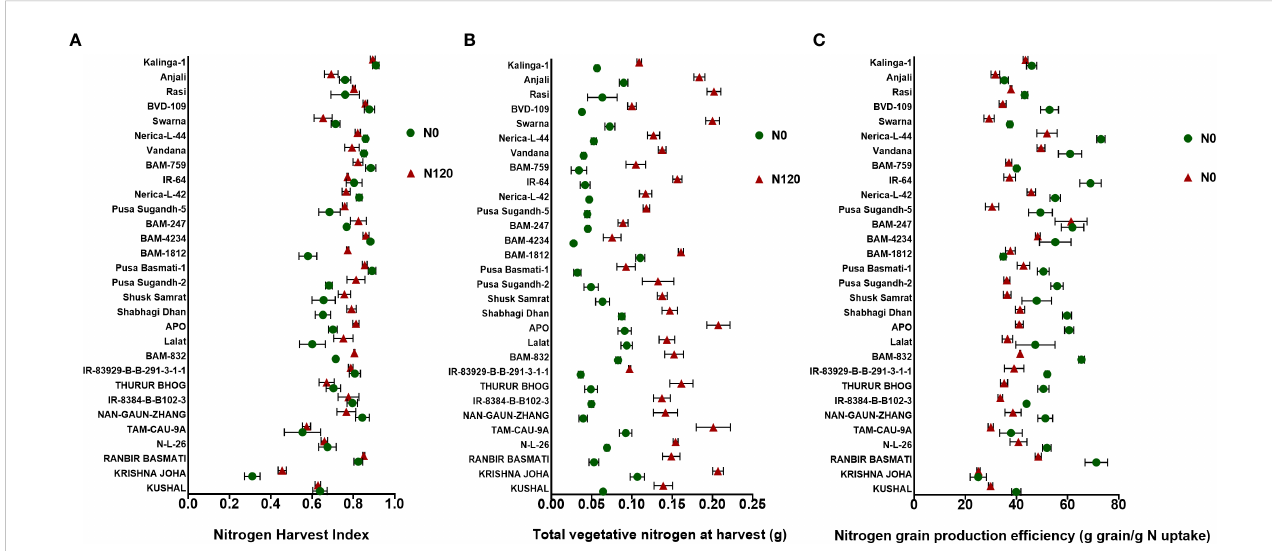
FIGURE 6 Effect of nitrogen de fi cient (0 kg ha-1 fertilizer N: N0) and nitrogen suf fi cient (120 kg ha-1 fertilizer N: N120) fi eld conditions on (A) Nitrogen Harvest Index, (B) Total vegetative nitrogen at harvest, and (C) Nitrogen grain production ef fi ciency in fi eld- grown diverse rice genotypes during the 2019-kharif season. Values presented are Mean±SE with three